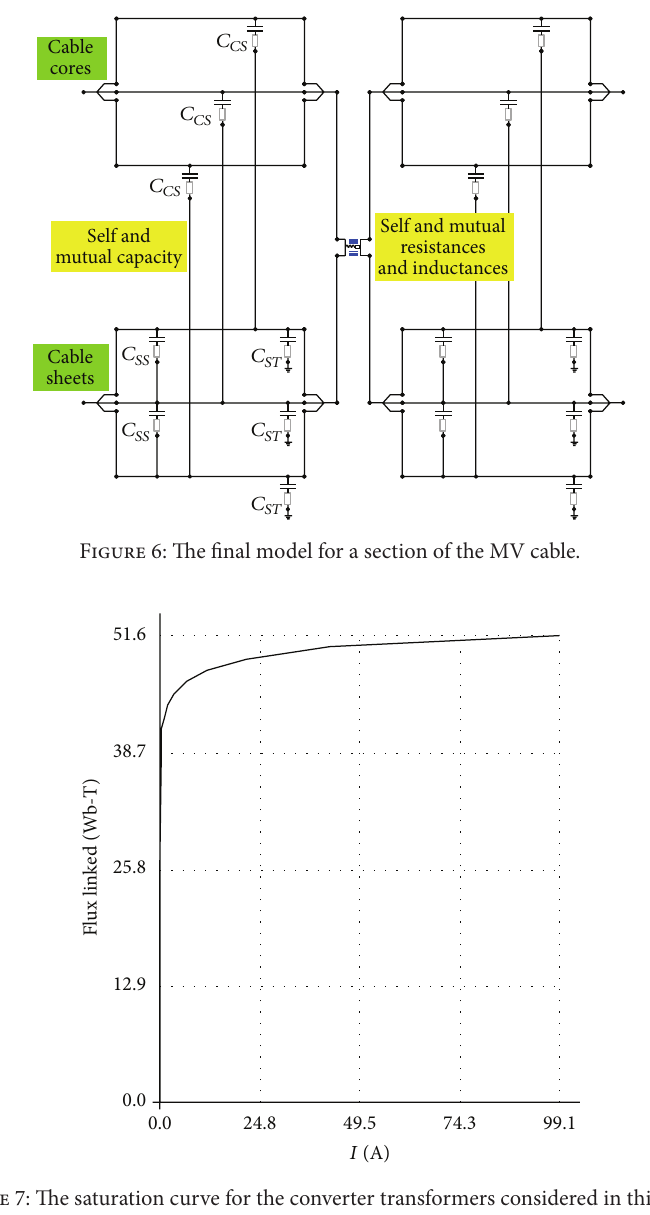
Figure 7: The saturation curve for the converter transformers considered in this